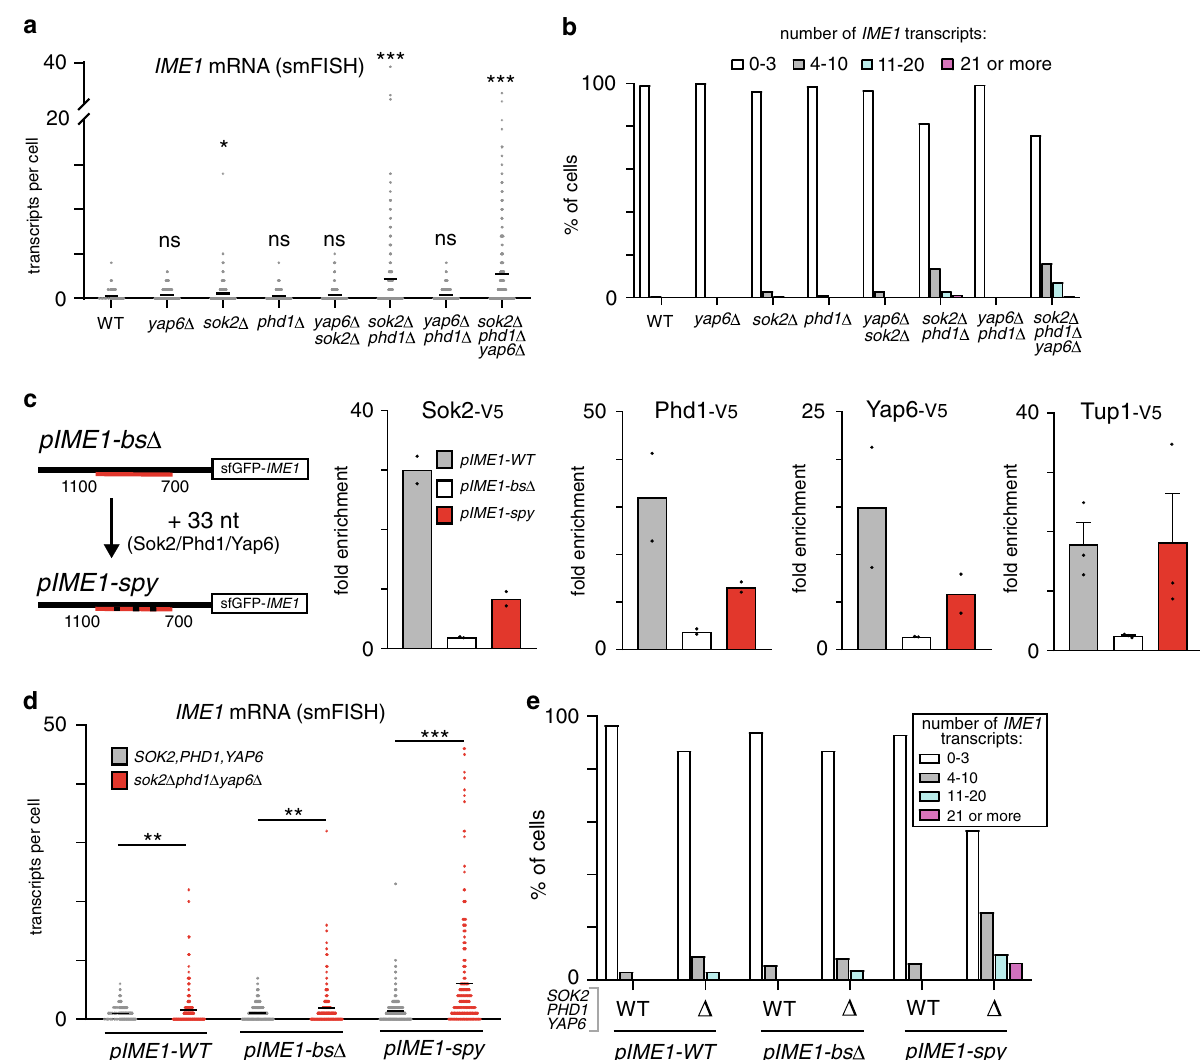
Fig. 5 Multiple Tup1 – Cyc8 interacting TFs repress IME1 in rich nutrients. a IME1 expression in single cells harbouring: sok2 Δ , phd1 Δ and yap6 Δ single deletions (FW3979, FW3991, FW3603); sok2 Δ phd1 Δ , yap6 Δ phd1 Δ and sok2 Δ yap6 Δ double deletions (FW4710, FW4406, FW4239); and sok2 Δ phd1 Δ yap6 Δ triple deletions (FW4010). Cells were grown to exponential phase in nutrient rich conditions (YPD), fi xed and hybridised with IME1 (AF594) and ACT1 (Cy5) probes. Only cells positive for ACT1 were used for the analyses. The mean number of transcripts per cell (black line) is displayed. Between 190 and 310 cells were used for the analysis. Unpaired parametric two-tailed Welch ’ s t test with 95% con fi dence was used to compare IME1 expression in mutant cells against wild-type control cells. Non-signi fi cant (ns) and p values (* = ≤ 0.05, *** = ≤ 0.001) are indicated. b Same data as in a , except that the single cell data for IME1 were binned according to expression levels. c Sok2, Phd1, Yap6 and Tup1 binding in cells harbouring the pIME1- WT (FW8081, FW8083, FW8079, FW5370), pIME1-bs Δ (FW8087, FW8089, FW8085, FW5372) and pIME1-spy (FW8093, FW8095, FW8091, FW7733) constructs as determined by ChIP. Mean of n = 2 are displayed, except for Tup1-V5 ( n = 3) for which the error bars represent SEM values. d IME1 expression in single cells as determined by smFISH in cells harbouring pIME1-WT , pIME1-bs Δ or pIME1-spy . These cells either expressed wild-type SOK2 , PHD1 and YAP6 (FW5370, FW5372, FW7733) or harboured the sok2 Δ phd1 Δ yap6 Δ triple deletions (FW7650, FW8420, FW8177). Unpaired parametric two-tailed Welch ’ s t test with 95% con fi dence was used. p values (** = ≤ 0.01, *** = ≤ 0.001) are indicated. e Same data as in d , except that the single cell data were binned according to IME1 expression